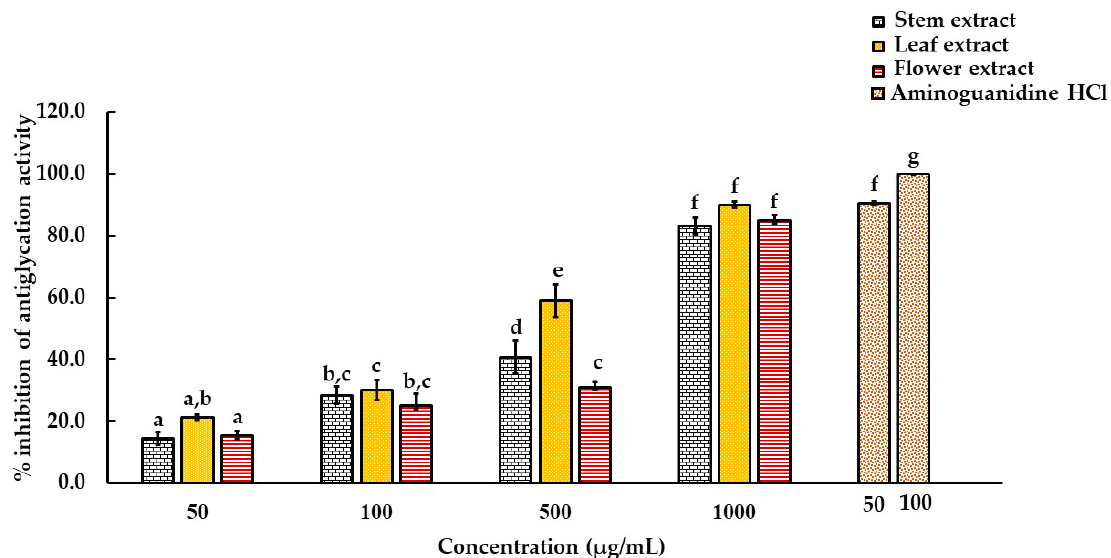
Figure 3. Effect of ethanolic extract of D. sulcatum stems, leaves and flowers on antiglycation activity using a BSA-fructose assay. Each value represents the mean ± SD ( n = 3). The different letters are significantly different ( p < 0.05) according to Tukey’s HSD test.